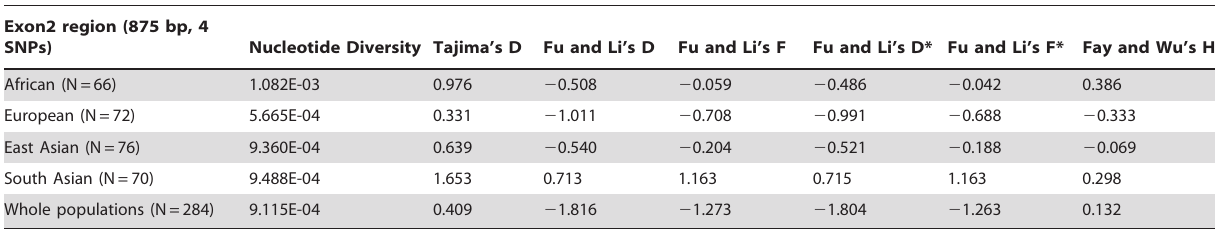
Table 2. Population statistics summary of exon 2 region.